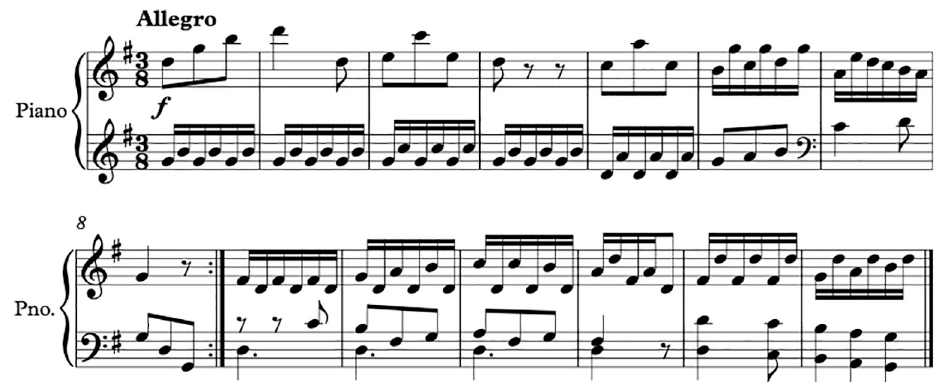
Fig 3. Excerpt of Haydn Hob 8. 4 th Movement- Original (Major key).